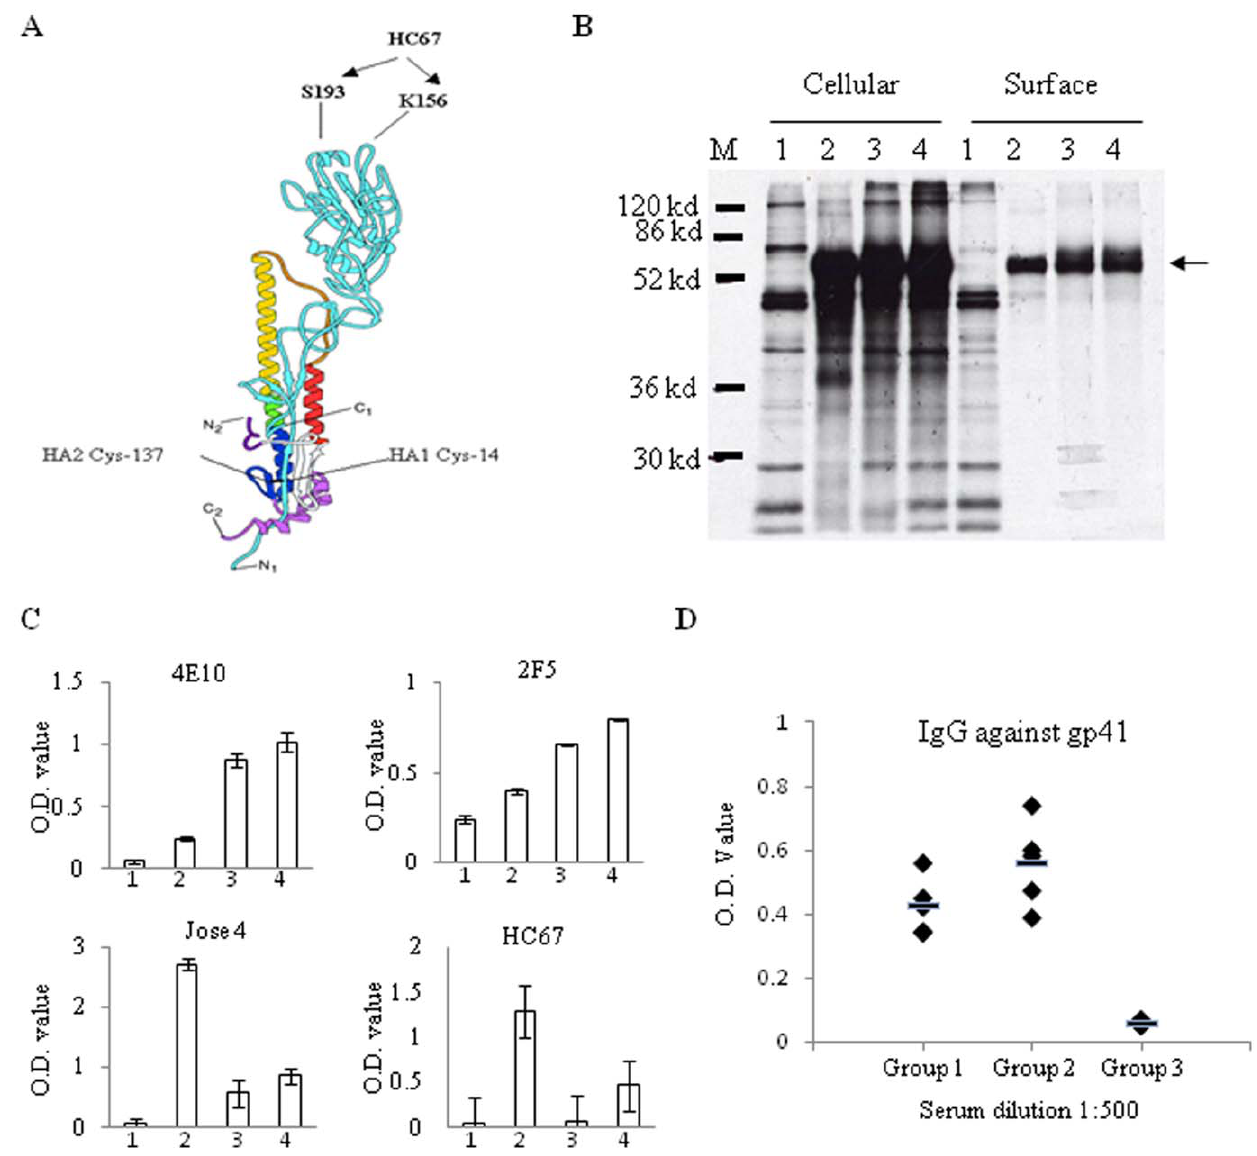
Figure 1. Characterization of the HA/gp41 and HA-C14S/gp41 chimeric proteins. A. Schematic diagram of the structure for influenza HA. Shown in the diagram are the positions of the Cys 14 of HA1 and Cys137 of HA2, which form a disulfide bond in the HA protein, and the position of the epitope (Ser 193 and Lys 156) recognized by the conformational antibody HC67 against HA. N1, C1, N2, and C2 represent N- and C-terminals of the HA1 and HA2 subunits respectively. B. Intracellular and surface expression of the HA/gp41 and HA-C14S/gp41 chimeric proteins. Protein expression was carried out using the recombinant vaccinia virus T7 expression system and detected by radioactive labeling coupled with surface biotinylation and immunoprecipitation using antibodies against HA as described in Materials and Methods. Lanes M, molecular weight marker; lanes 1, mock transfection by a plasmid DNA vector; lanes 2, influenza HA; lanes 3, HA/gp41; lanes 4, HA-C14S/gp41. Arrow indicates the position of the HA, HA/gp41, as well as HA-C14S/gp41 proteins in the SDS-PAGE. C. Comparison of antibody binding to HA, HA/gp41, and HA-C14S/gp41 by cell surface ELISA. Protein expression was carried out in a 96-well plate in triplicates as described above. At 16 hr post transfection, cells were fixed and then incubated with different antibodies at room temperature for 2 hr, including human MAbs 4E10 and 2F5 against gp41, rabbit polyclonal antibody Jose4 against HA, and a conformation-sensitive mouse MAb HC67 against HA as indicated. After incubation with primary antibodies, HRP-conjugated Goat-anti-human, rabbit, or mouse secondary antibodies were added to detect the amounts of the indicated antibody that bound to the cell surfaces, which were expressed by the average O.D. value from the wells expressing each protein and binding to each primary antibody respectively. 1, mock transfection by plasmid DNA vector; 2, influenza HA; 3, HA/gp41; 4, HA-C14S/gp41. D. Induction of gp41-specific antibodies by HA/gp41 and HA- C14S/gp41 DNA vaccines in mice. Mice (groups of 6) were immunized by HA/gp41 and HA-C14S/gp41 DNA vaccines twice at 4-week intervals, and blood samples were collected at 2 weeks after the second immunization for analysis of antibody responses against gp41 by ELISA. The levels of antibodies against gp41 in sera from individual mice in each group were expressed by O.D. values at 1:500 serum dilution. Group1, immunization with HA/gp41 DNA vaccine; Group 2, immunization with HA-C14S/gp41 DNA vaccine, Group 3, immunization with plasmid DNA vector pCAGGS.